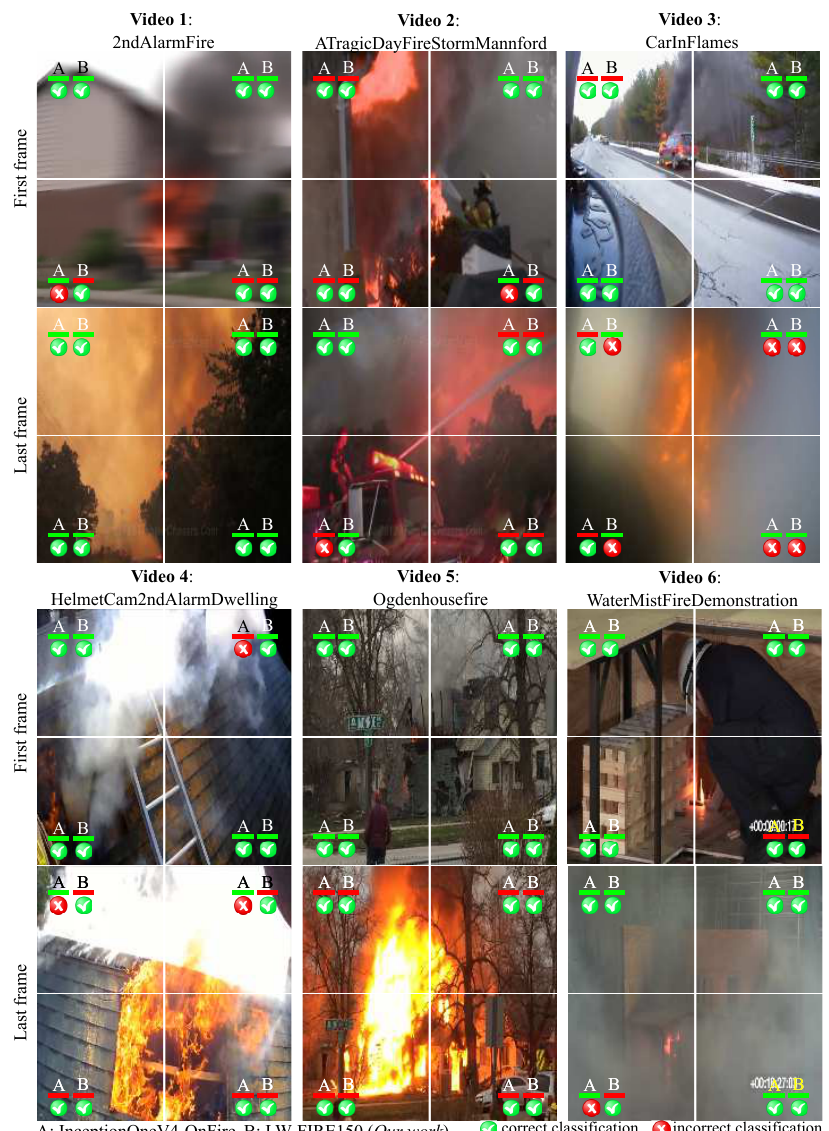
Figure 8. The performance of two models: (A) InceptionOneV4-OnFire, which has the best overall performance on this dataset out of the state of the art models, and (B) our LW-FIRE150 42 . We used the first and last frame from the six video sources from the dataset [6] to present various fire conditions. We tested models on 2 × 2 sub-images. The models’ prediction results are indicated with green and red bars, where the green bar indicates that the fire was not detected, while the red bar indicates the presence of fire in the sub-image. Under each bar, we present the correct classification results. (Best viewed in